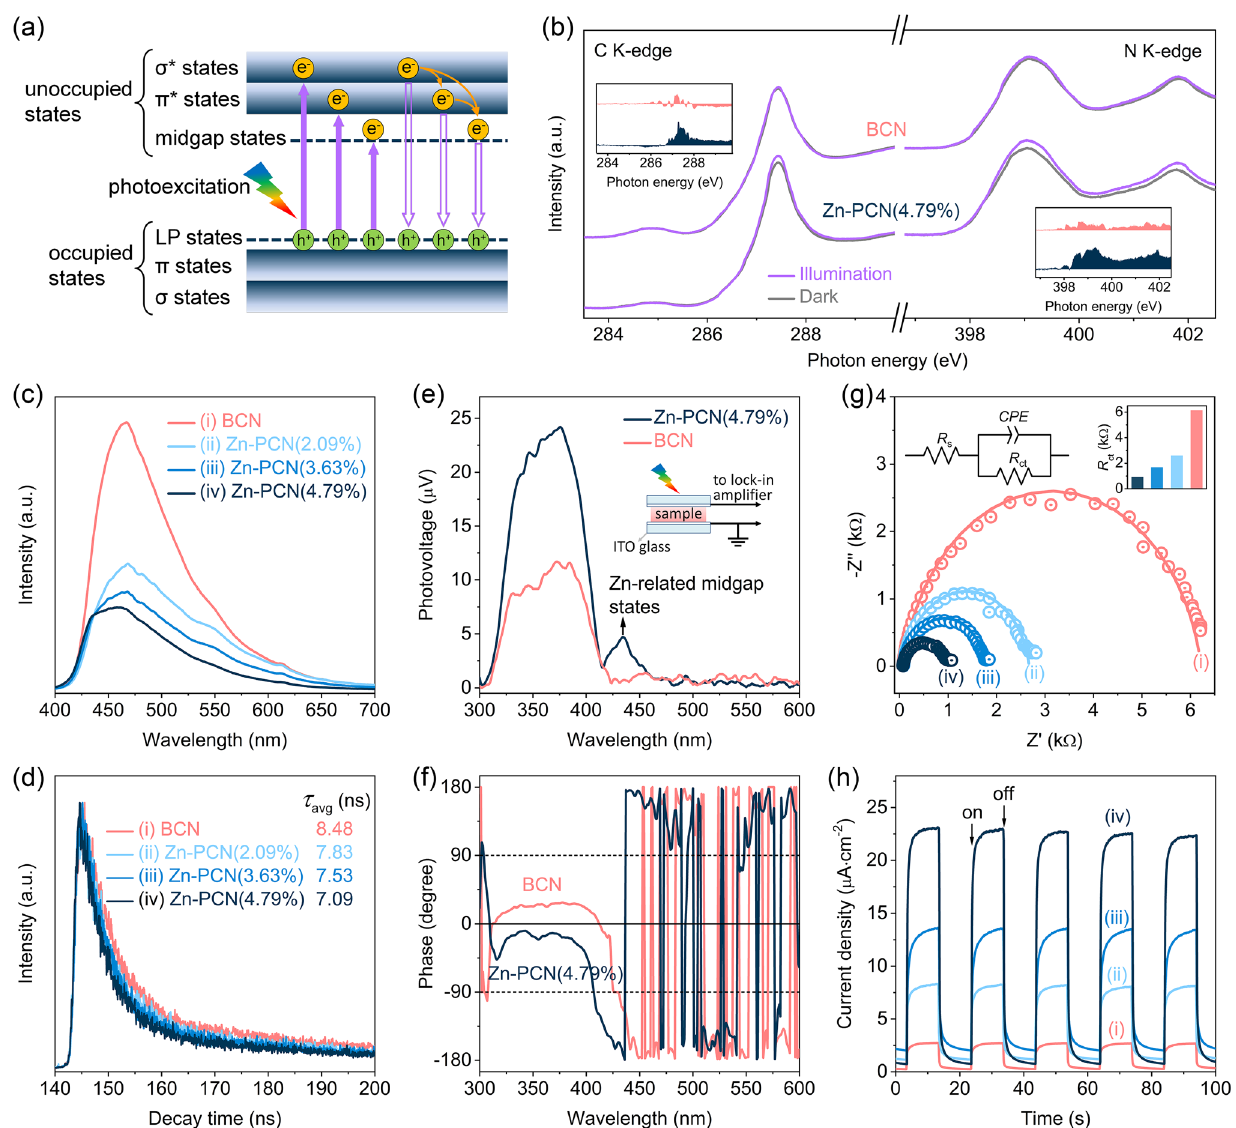
Fig. 4 a Illustration of the electron transition processes in Zn‑PCN. b C K‑edge and N K‑edge XANES spectra of BCN and Zn‑PCN(4.79%) with or without illumination. The inset in b shows the spectral difference between being in dark and light. c Steady‑state PL emission spectra and d time‑resolved transient PL decay spectra of BCN and Zn‑PCN. The excitation wavelength for all samples is 337 nm. e SPV spectra of BCN and Zn‑PCN(4.79%) and f corresponding phase spectra. The inset in e shows the schematic setup for the SPV measurements. g Electro‑ chemical impedance spectra of BCN and Zn‑PCN at 0.8 V versus Ag/AgCl in 0.5 M Na 2 SO 4 aqueous solution under light irradiation. The left inset in g is an equal circuit for the catalyst/electrolyte interfaces. R s is the electrolyte resistance. R ct and CPE is the charge transfer resistance from the bulk to the surface of photocatalyst and the constant phase element, respectively. The right inset in g presents the corresponding R ct val‑ ues. h Transient photocurrent density curves of BCN and Zn‑PCN at 0.2 V versus Ag/AgCl in 0.5 M Na 2 SO 4 aqueous solution under sequential illumination condition with an interval of 10 s on/off